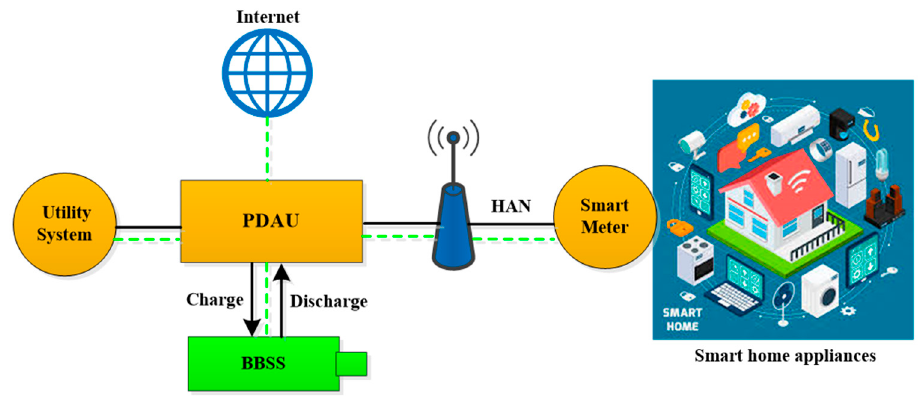
Figure 2. Advanced smart metering architecture in the smart grid framework.